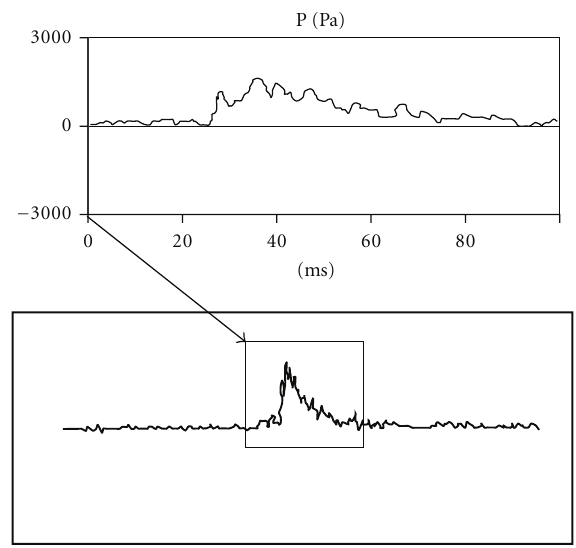
transverse and longitudinal sections of the channel indicate that the twist flow is saved along the entire length of the channel. The increase in ejection of air with open entrance of the reactor caused by the intensification of the mixing process for swirling annular jet due to additional azimuthal velocity